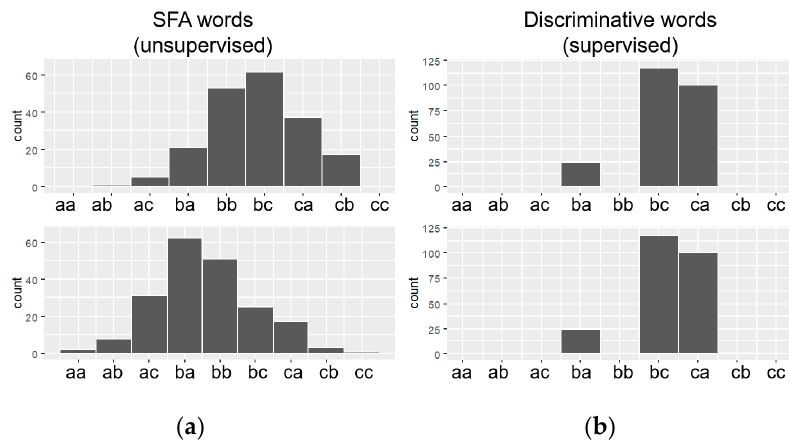
Figure 13. Difference between the histograms generated by the SFA ( a ) and SFA-W ( b ).